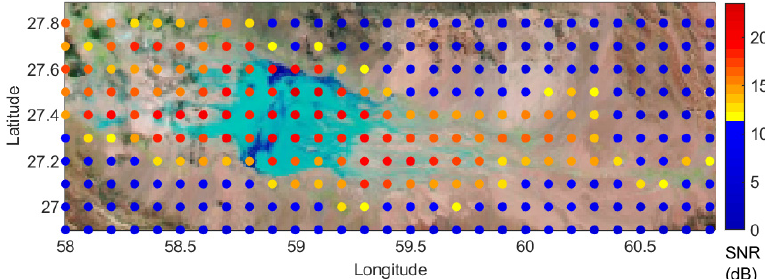
Figure 11. The georeferenced optical satellite imagery of the flood over the Hamun-Jaz Murian basin (region A in Figure 10) from MODIS (13 January 2020) overlaid by the corrected SNR derived from